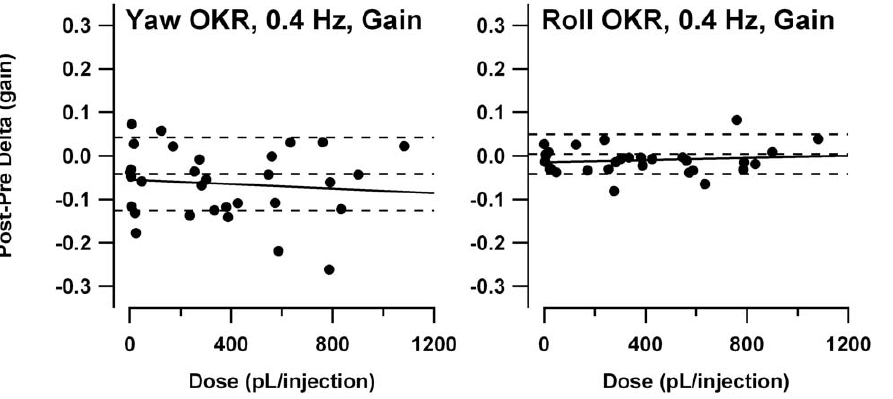
Figure 11. Change in sinusoidal OKR gain following intrafloccular 4-AP injections in tottering , plotted as a function of volume of each injection. Left panel: yaw OKR. Right panel: roll OKR. Horizontal dashed lines indicate the mean and 6 2SD confidence interval for gain change in the systemic saline sessions of young tottering . 4-AP did not engender any changes in gain proportional to drug dosage.